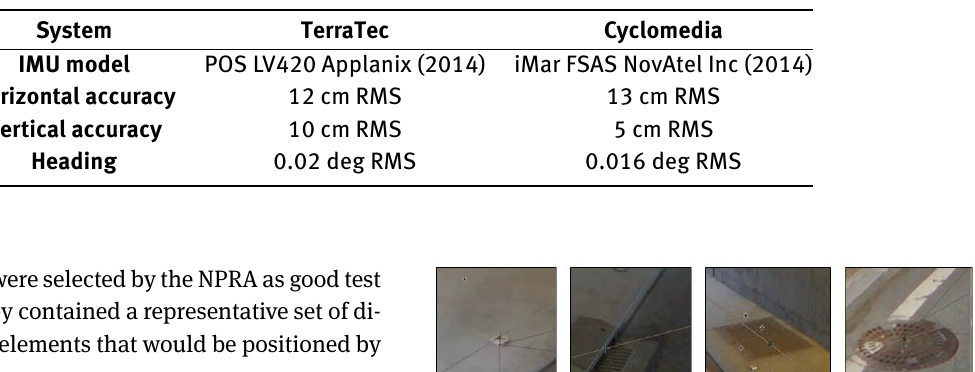
Table 1: Best expected performance of the underlying IMUs of the two positioning systems when encountering a GNSS outage, such as a tunnel, of 60 seconds.